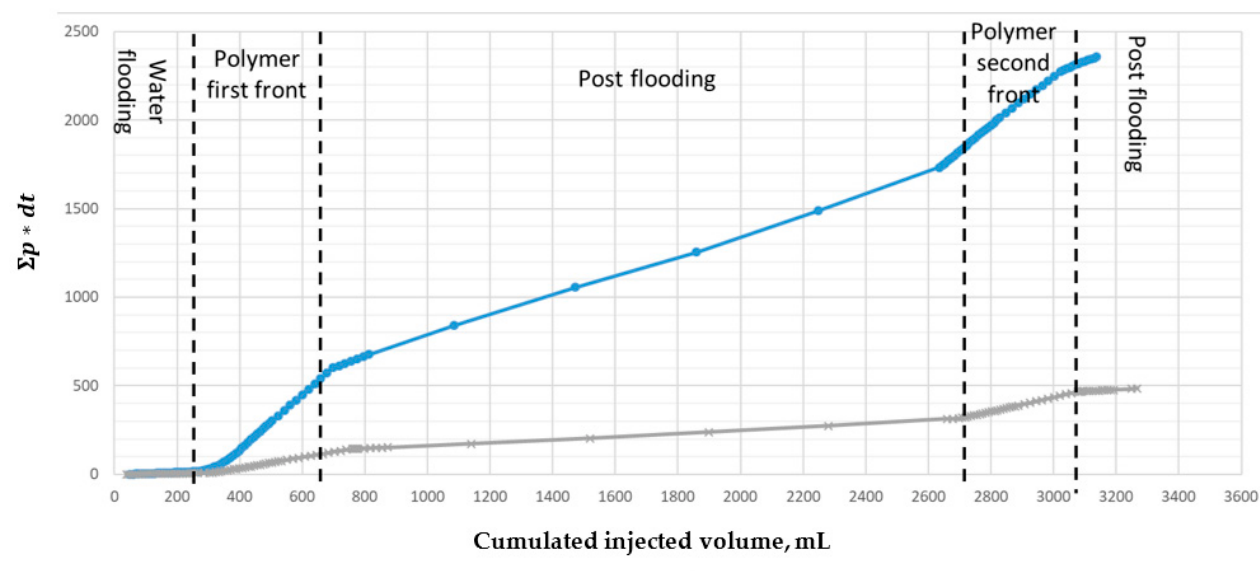
Figure 7. Hall plot for the entire core model at equal viscosities of the polymer solution (10 cP at 7.3 s − 1 ) during experiments No. 2 and 6, upper and lower curves respectively. P stands for pressure while d t stands for time increment.